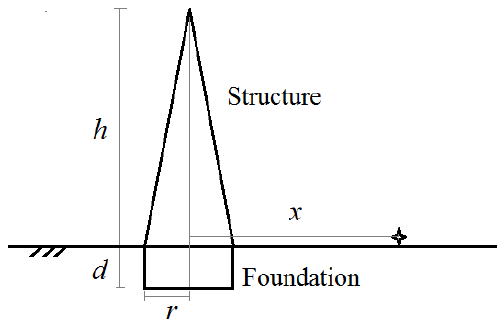
Figure 3 . Conical structure with a cylindrical foundation considered for the calculation. Figure 3. Conical structure with a cylindrical foundation considered for the